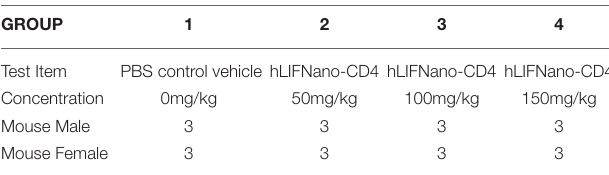
Experimental observations and measurements: Mortality, clinical observations up to 7 days, post-dose observations (0.5, 1, 2, 4, 24h), body weight (7d), clinical toxicity assessment, haematology, clinical chemistry (at day 7). Blood and organs collected for analysis and histology. Main conclusions: LIFNano-CD4 is tolerated at 50mg/kg. Mild-moderate transient toxicity observed at 30-60min post iv administration at 100 and 150 mg/kg, which resolved at 2h. Haematology and clinical chemistry parameters all within normal range, but some parameters elevated in a dose-dependent manner which may indicate